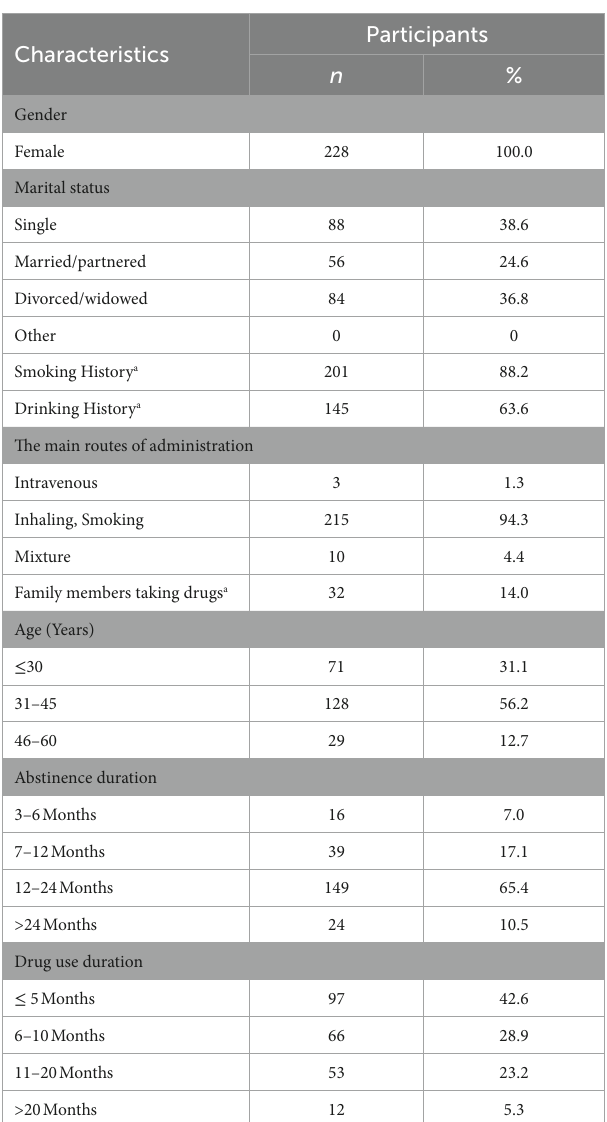
TABLE 1 Sociodemographic characteristics of participants.